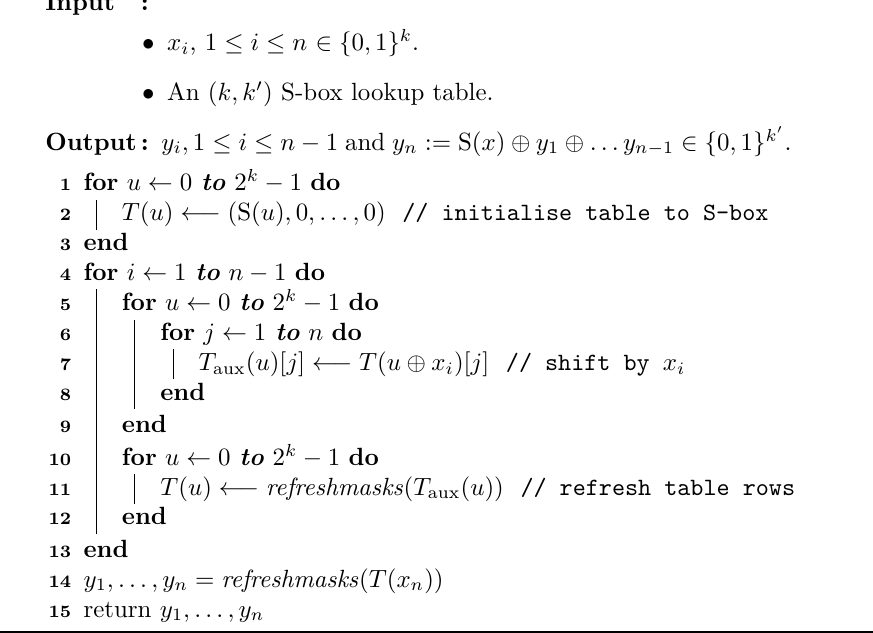
Algorithm 2: Computation of y = S( x ) using higher-order masked lookup table computation [CRZ18, Algorithm 1, Section